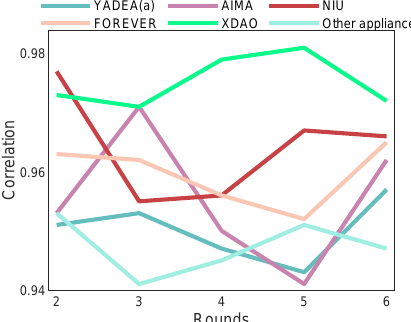
Figure 10. 2D correlation of 5 rounds over period of 30 days.